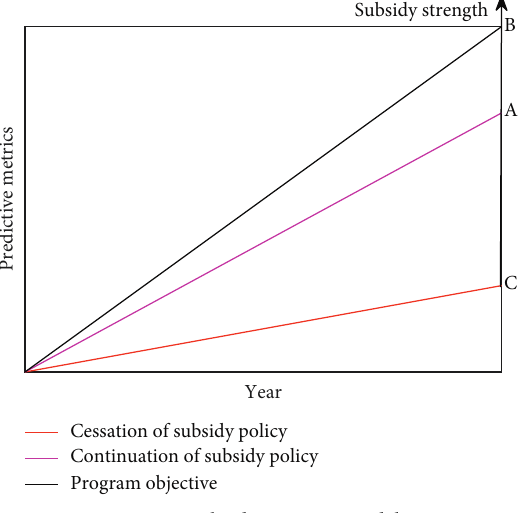
Figure 7: Subsidy strategy model 2.